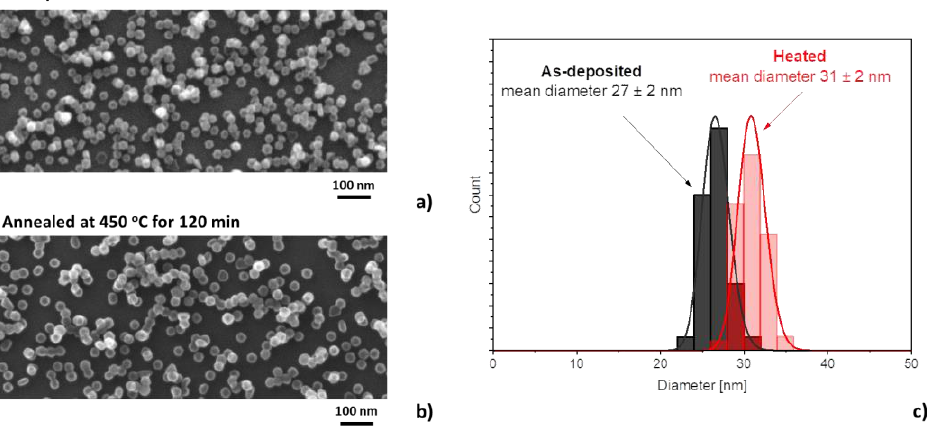
Figure 4. SEM images of ( a ) as-deposited and ( b ) annealed Ti nanoparticles. ( c ) Comparison of size histograms of as-deposited and annealed Ti nanoparticles.